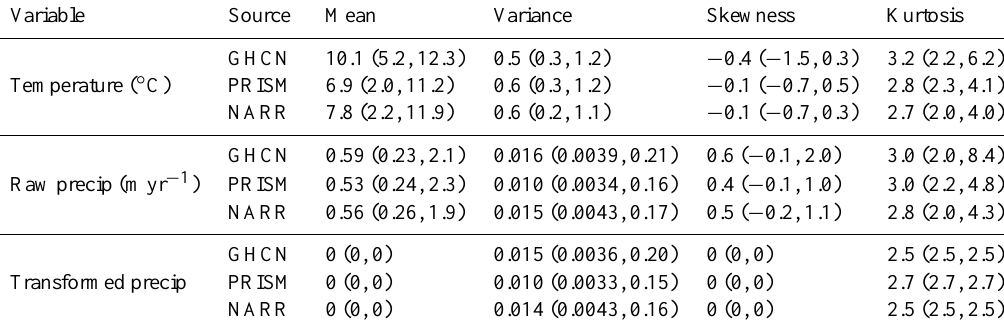
Table 2. Statistics of annual climate data for both temperature and precipitation. Results for precipitation are shown for both the raw data and after the transformation to Gaussian, as described in the text. For each statistic, the median for all grid cells is listed followed by the 5th and 95th percentile values in parentheses. Note that a Gaussian distribution has a skewness of 0 and a kurtosis of 3, but that with smaller sample sizes a discrete approximation to a Gaussian results in slightly lower values for the